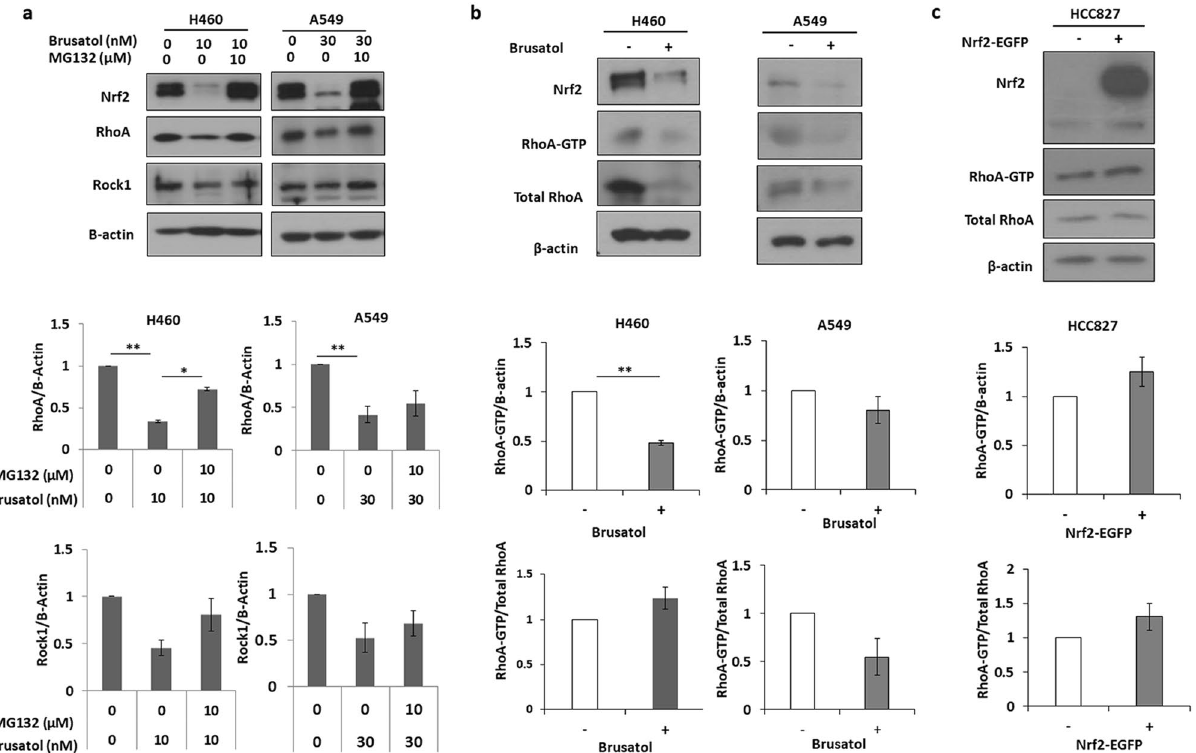
Figure 4. Nrf2 increases the stability or activity of RhoA. ( a ) Cells were treated with MG132 with or without brusatol for 3 h and then harvested for western blotting. ( b , c ) Activation of RhoA was measured using RhoA Pull-down activation assay. RhoA-GTP was detected by western blotting. A549 and H460 cells were treated with brusatol (15 nM and 10 nM) for 24 h. HCC827 was transfected by exogenously introduced Nrf2-EGFP for 24 h. The densitometry quantification of the western blot determined using Image J software (Ver. 1/52n,